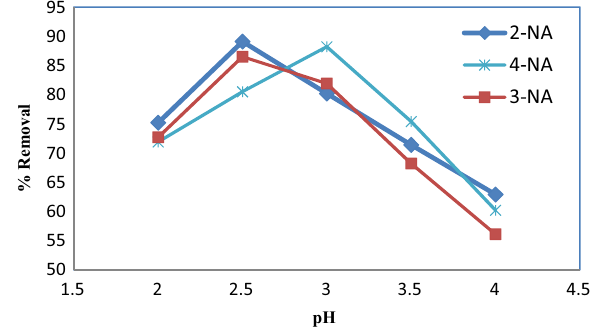
Fig. 1 Effect of pH on removal of 2-NA, 3-NA and